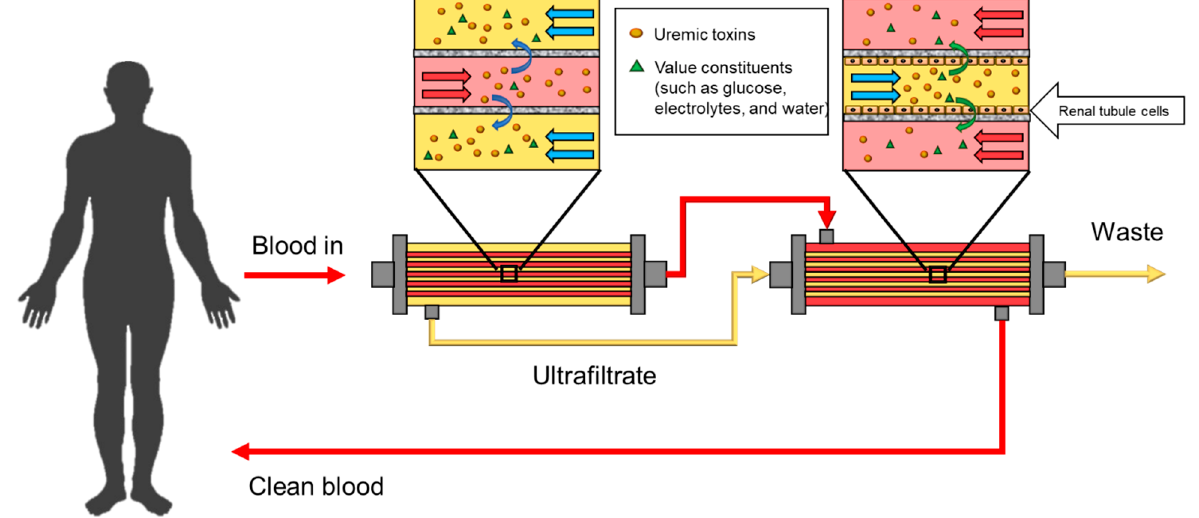
Figure 13. Bioartificial kidney (BAK) schematic.